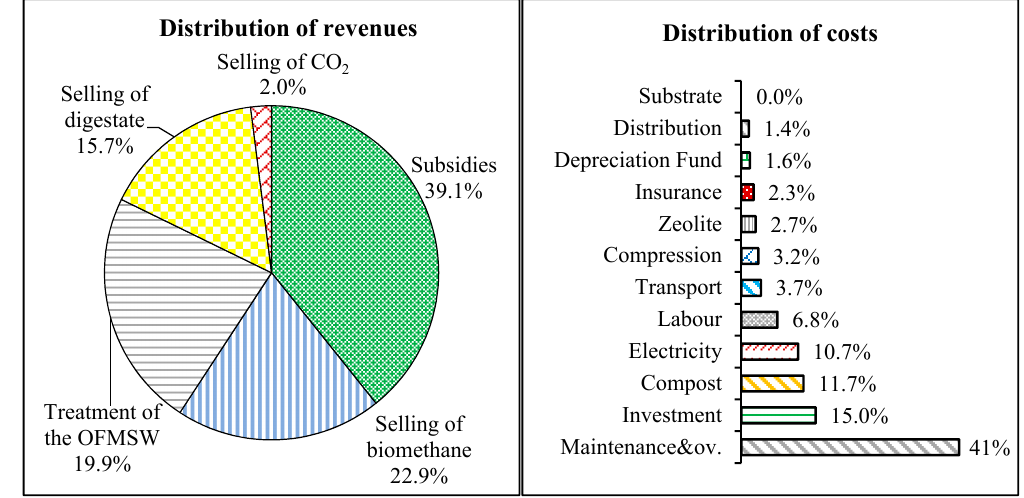
Figure 4. Distribution of discounted cash flows (%)—baseline scenario. OFMSW—organic fraction of municipal solid waste.